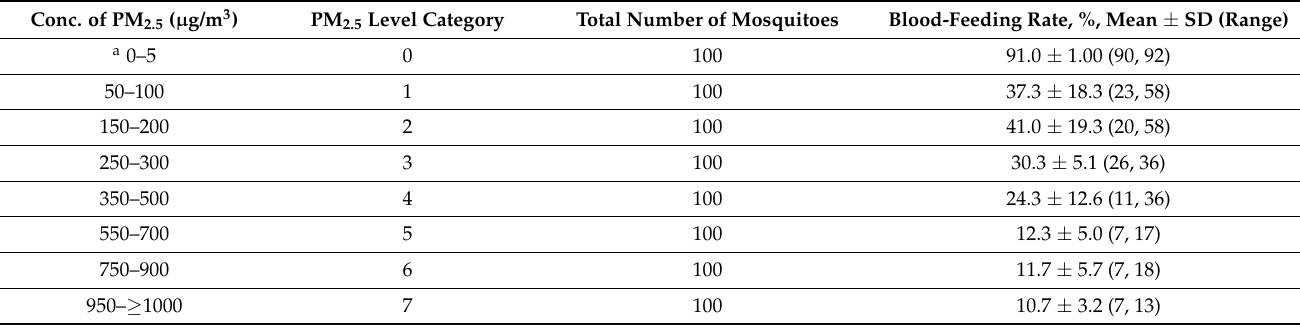
Table 1. Blood-feeding rates in female Ae. aegypti mosquitoes stratified by PM 2.5 concentration. Conc. of PM 2.5 ( µ g/m 3